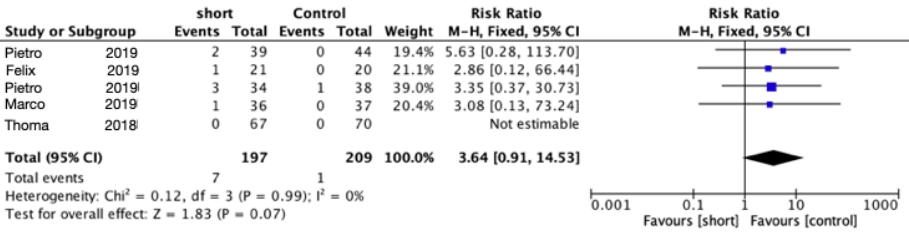
Figure 2. Comparison of implant failures using short implants vs. longer implants with elevation of the sinus floor after 5 years in function via a meta-analysis.